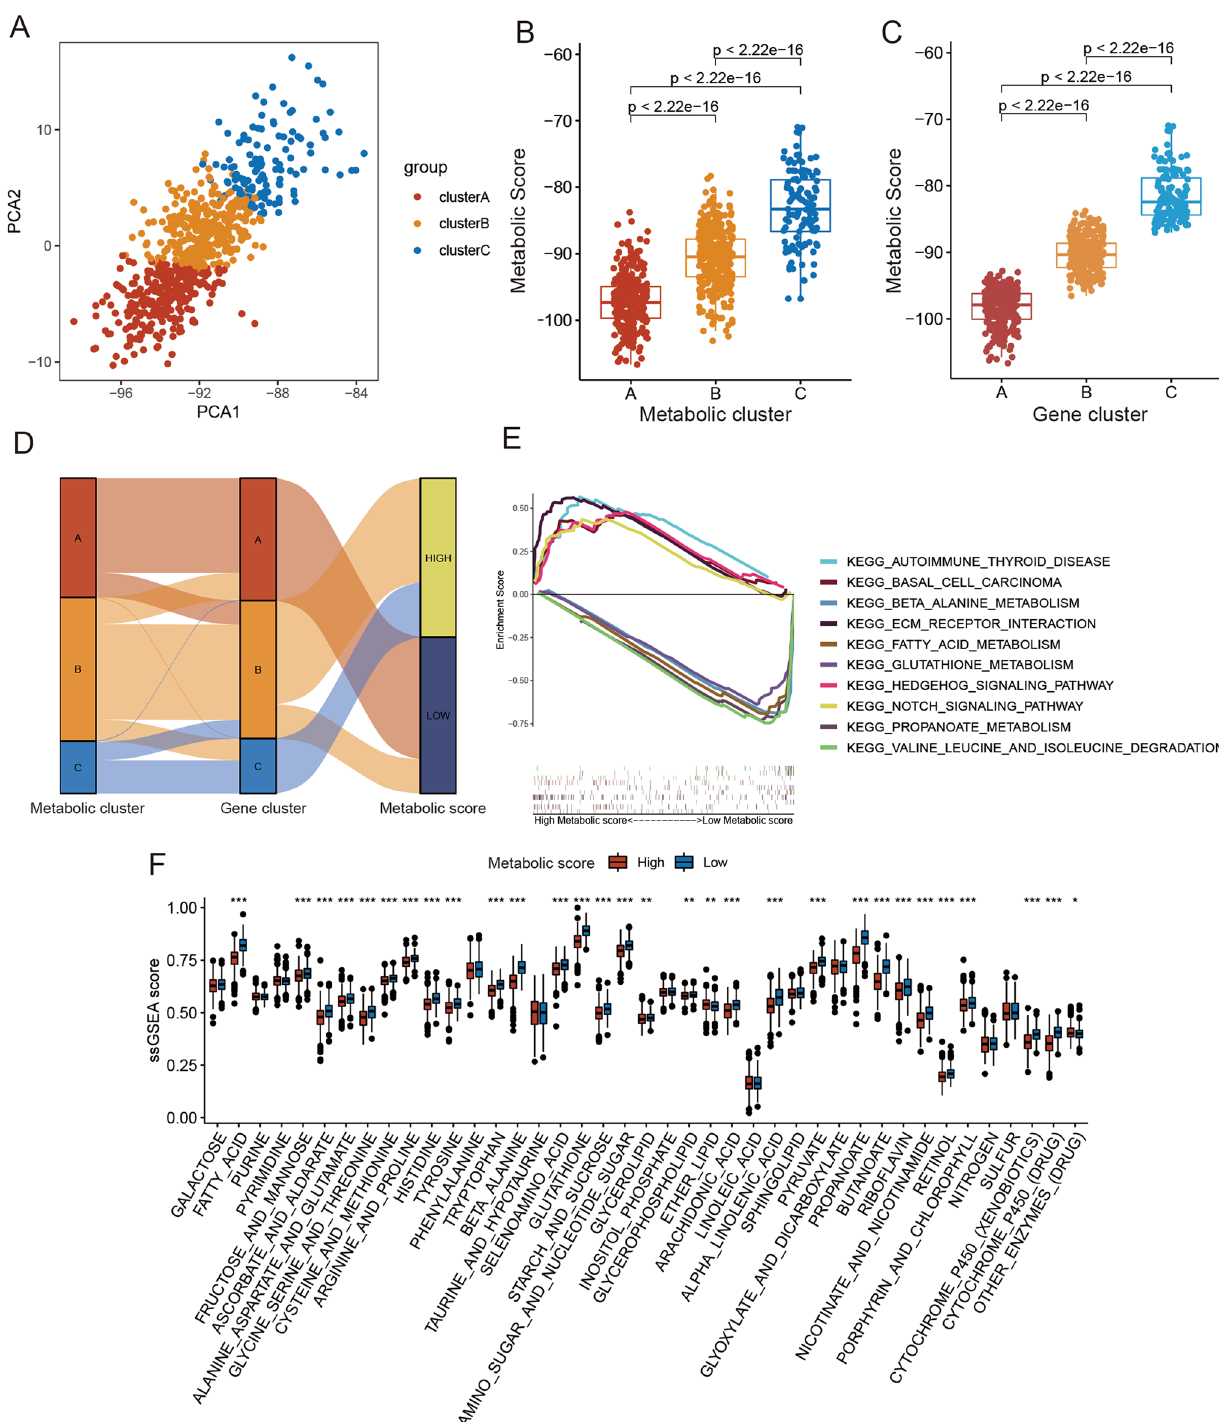
Figure 3. Construction of the metabolism-score. ( A ) Principal Component Analysis (PCA) based on metabolic gene signatures expression. ( B ) Boxplot of metabolic score for three metabolism clusters in the meta cohort. ( C ) Boxplot of metabolic score for three metabolic gene clusters in the meta cohort. ( D ) Alluvial diagram of metabolic gene cluster distribution in groups with different metabolism clusters, gene clusters, and metabolic score. ( E ) Enrichment plots showing autoimmune thyroid disease, base excision repair, ECM receptor interaction, intestinal immune network for IGA production, and notch signaling pathway in the low metabolism-score subgroup, and showing beta-alanine metabolism, butanoate metabolism, fatty acid metabolism, propanoate metabolism, and valine leucine and isoleucine degradation in the high metabolism- score subgroup. ( F ) The metabolic ssGSEA scores in high and low metabolic score groups. The statistical difference of two groups was compared through the Wilcoxon test. * p < 0.05; ** p < 0.01; *** p <